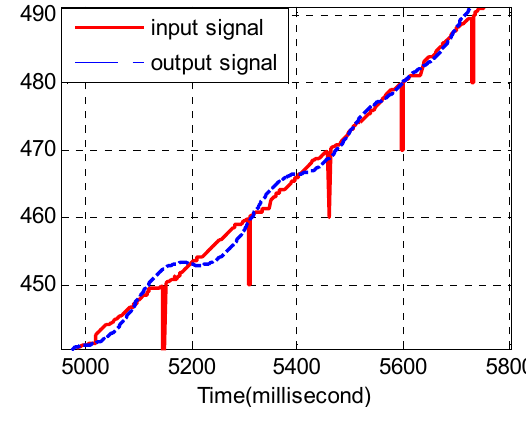
Figure 13. Comparison of the input signal and the output